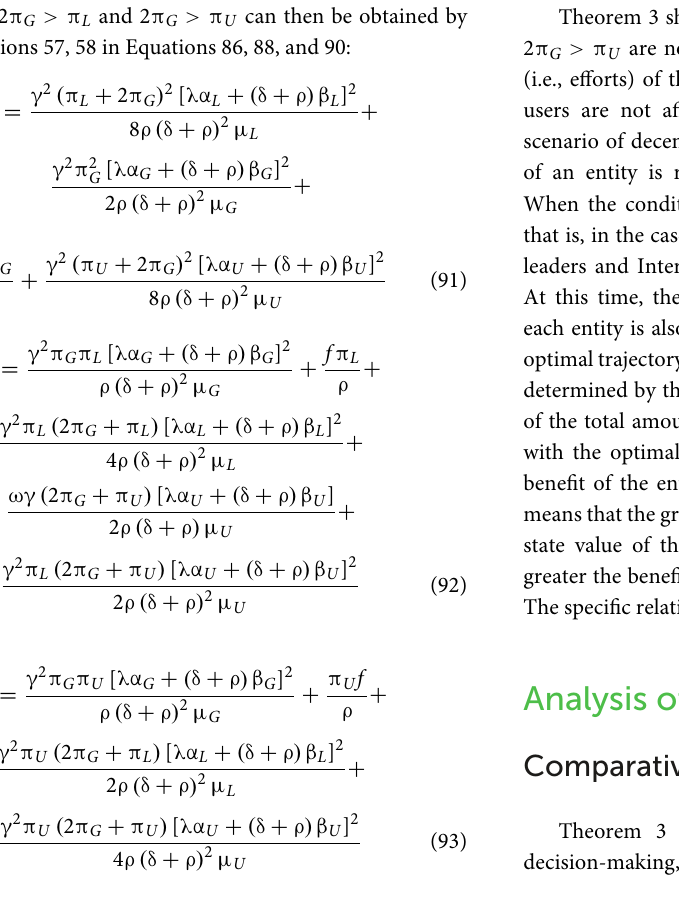
TABLE 3 The effects of the parameters on the optimal equilibrium strategies of the government, opinion leaders, and Internet users under cost-subsidized